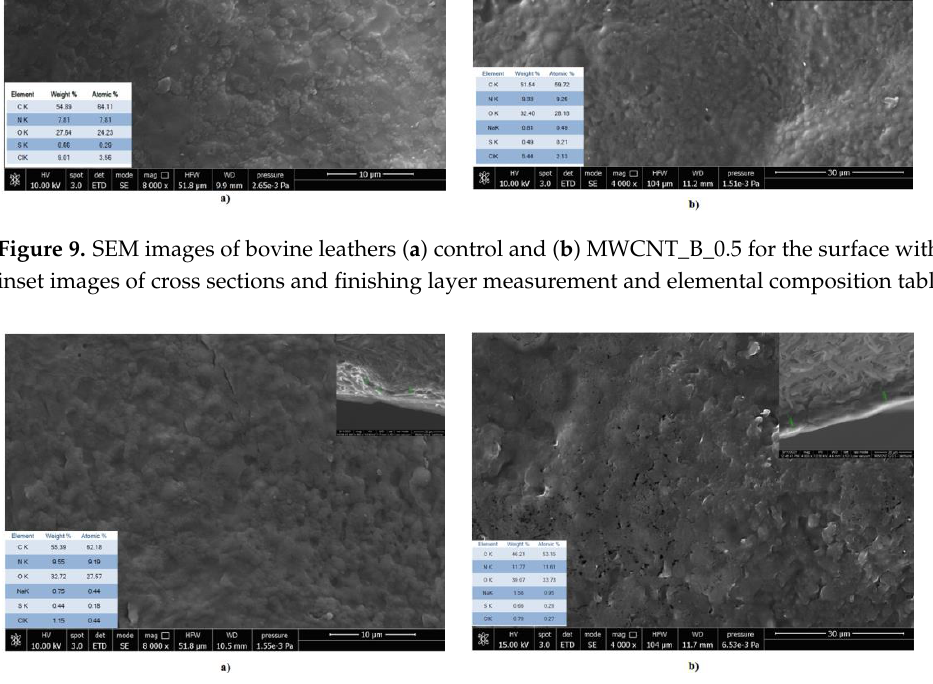
( b ) Figure 11. XPS spectrum of the ( a ) bovine control leather surface and ( b ) MWCNT_B_0.5.